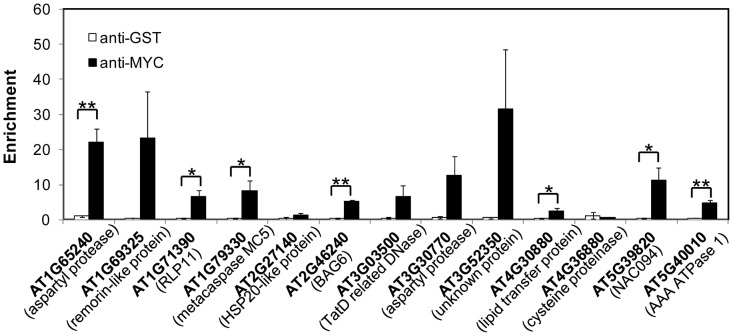
NAC089 binds to the promoter regions of target genes.Enrichment is the DNA level of each fragment in beta-estradiol (BE)-treated sample divided by that in DMSO-treated sample, both of which were normalized to the level of TA3. Anti-MYC antibody was used to precipitate NAC089D-MYC and anti-GST was used as a negative antibody control. Bars depict SE (n = 3). ** P<0.01, * P<0.05 except for AT1G79330 (p = 0.057).